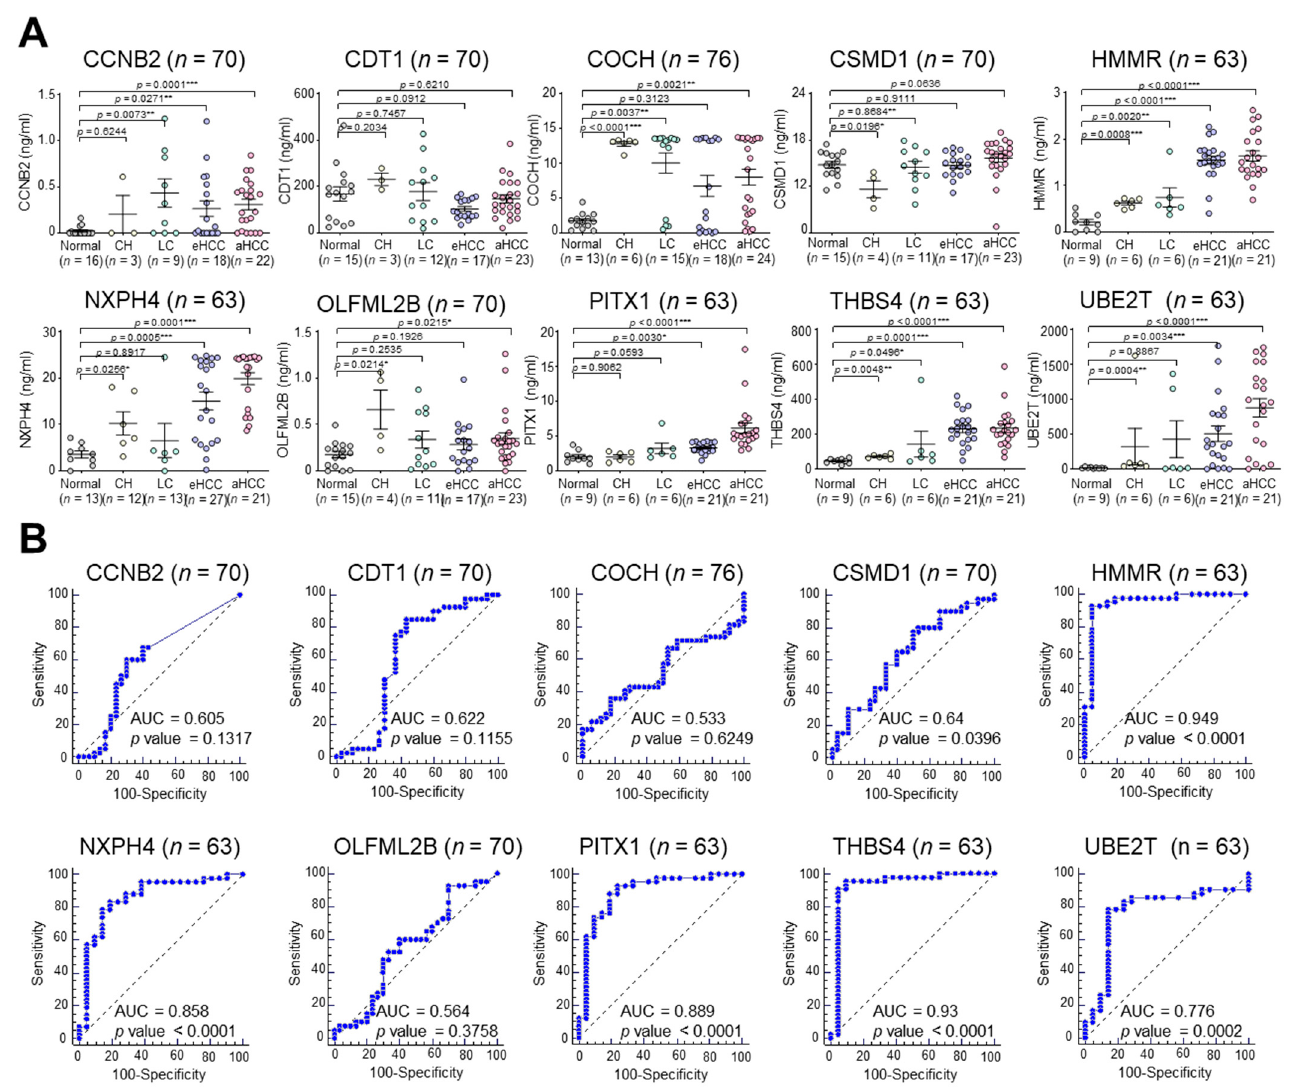
Figure 3. Concentration of 10 secretory proteins in serum in the test set. ( A ) Expression of 10 candidate gene products based on ELISA are presented as an aligned dot plot. Black horizontal lines are means, and error bars are SEs. Mann–Whitney U test, p < 0.05 *, p < 0.01 **, p < 0.001 ***. CH, chronic hepatitis B virus infection; LC, liver cirrhosis; eHCC, early-stage hepatocellular carcinoma; aHCC, advanced hepatocellular carcinoma. ( B ) ROC curve analysis of the secretory proteins encoded by the 10 candidate genes. Statistically significant difference of AUC is compared with reference line (AUC = 0.5).